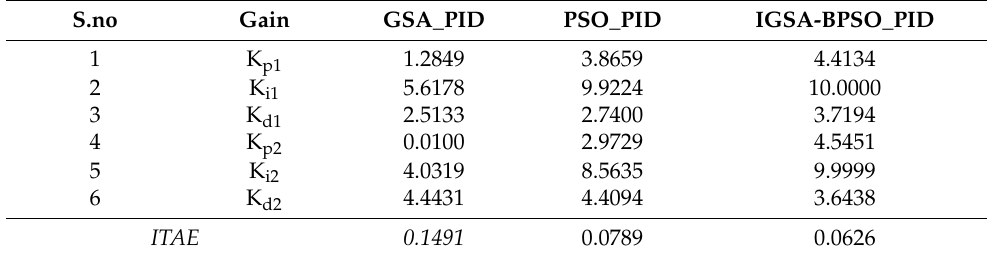
Table 4. PID parameters tuning for hybrid test system and ITAE values: BBT.